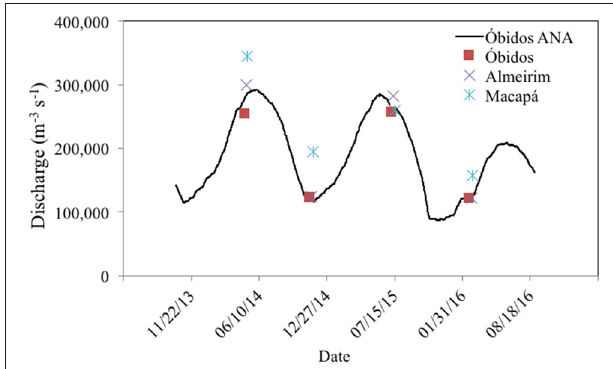
FIGURE 7 | Discharge measurements in the four cruises in the different hydrological phases compared with data from the Brazilian Water Agency (ANA) monitoring station at Óbidos.